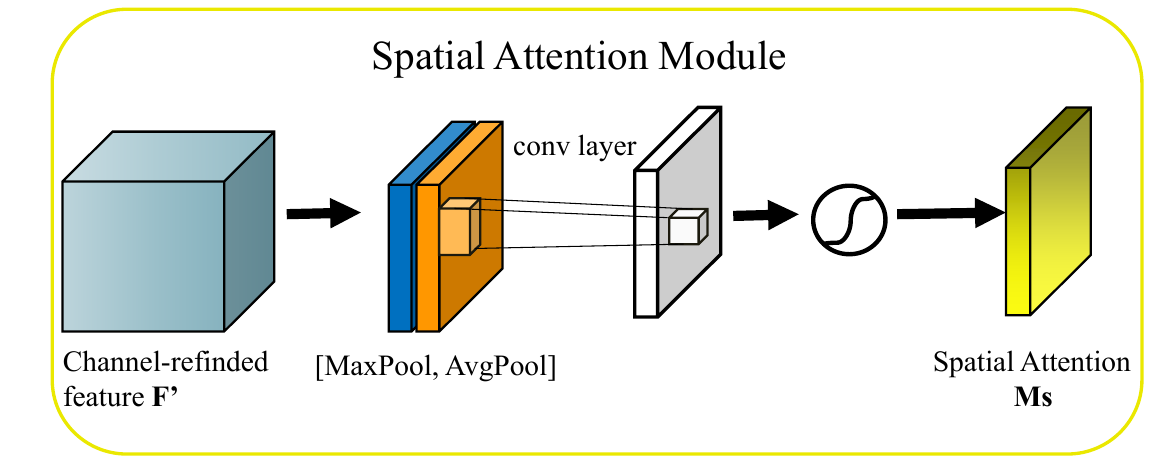
Figure 4. The structure of the Spatial Attention Module.